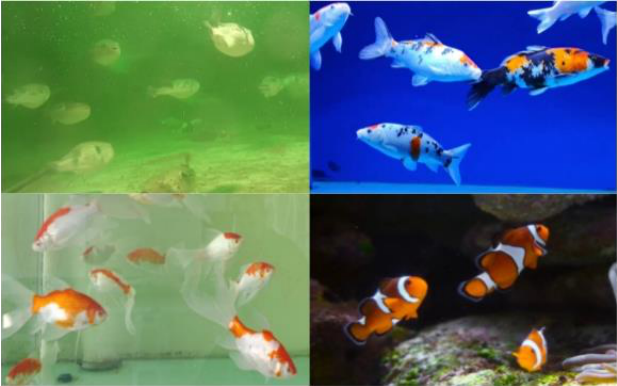
Figure 10. Sample graph of the dataset.